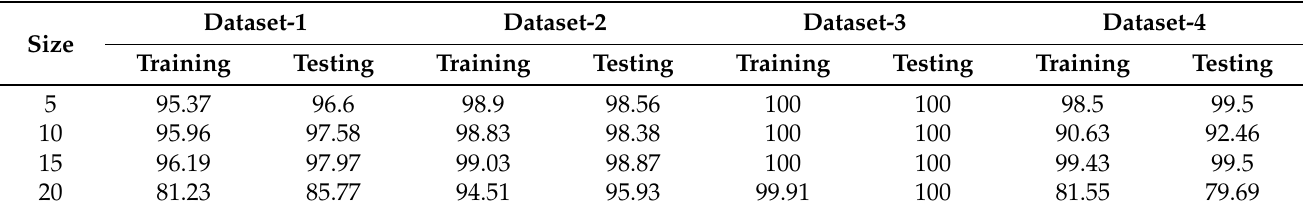
Table 6. Accuracy of DNN model with respect to batch size.